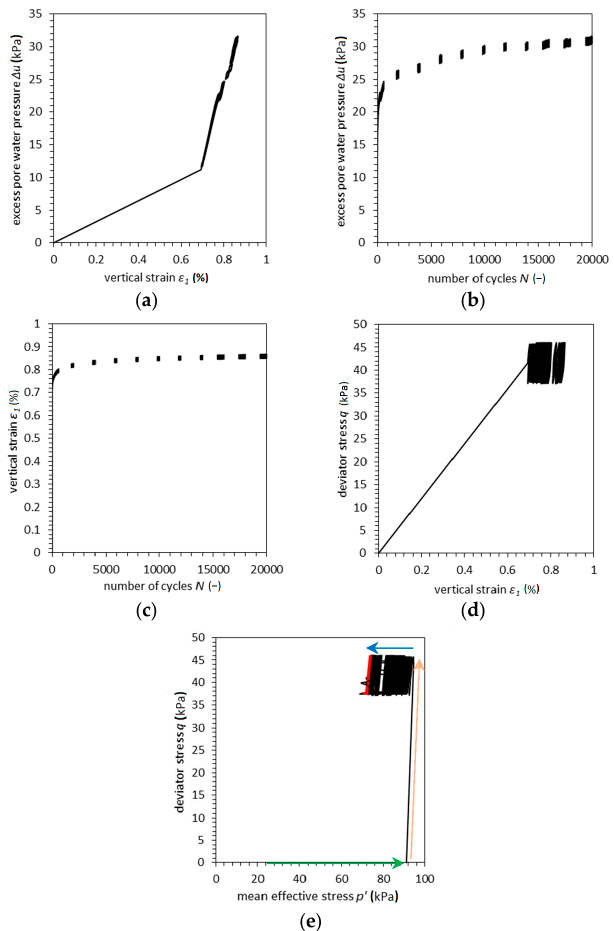
Figure 3. Results of the cyclic triaxial test for sandy silty clay under a confining pressure of 90 kPa and under the isotropic consolidation, initial void ratio e 0 = 0.345—sample 1.2: ( a ) Excess pore water pressure versus vertical strain characteristic, ( b ) excess pore water pressure characteristic versus number of cycles, ( c ) vertical strain characteristic versus number of cycle, ( d ) deviator stress–vertical strain relationship, and ( e ) the deviator stress–mean e ff ective stress relationship (red color—last 10 cycles; arrow color—violet: Saturation phase, green: Consolidation phase, orange: First cycle of cyclic loading, blue: Cyclic loading